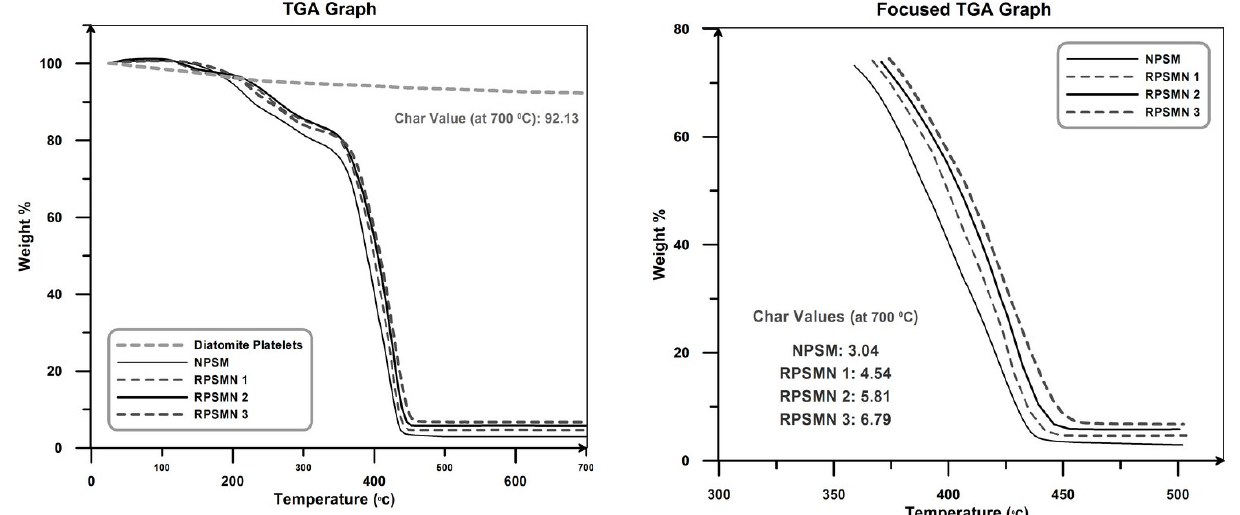
Figure 9: TGA curves of the neat poly (styrene-co-methyl methacrylate) and its nanocomposites in two different